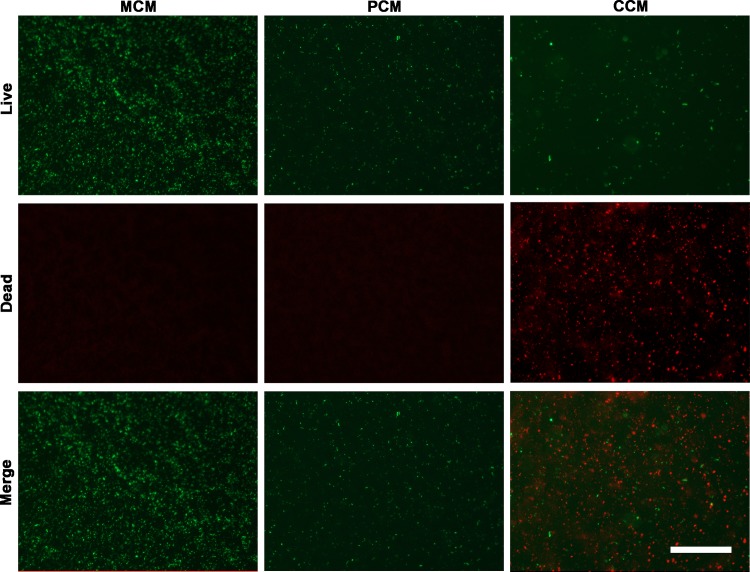
The antimicrobial properties on the surface of three substrates for 4 h.Scale bar: 100 μm. Dead bacteria are expressed in red, living bacteria expressed in green.